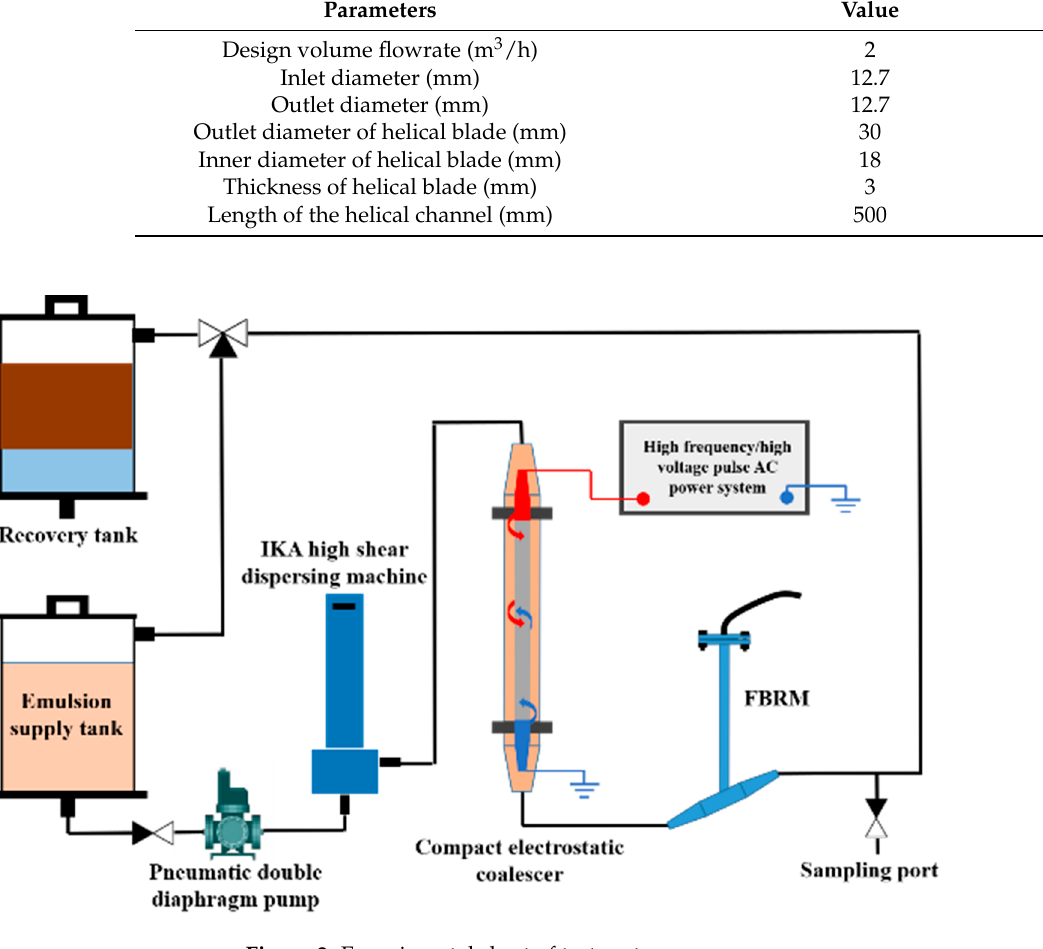
Figure 2. Experimental chart of test system. Table 1. The main parameters of compact electrostatic coalescer.